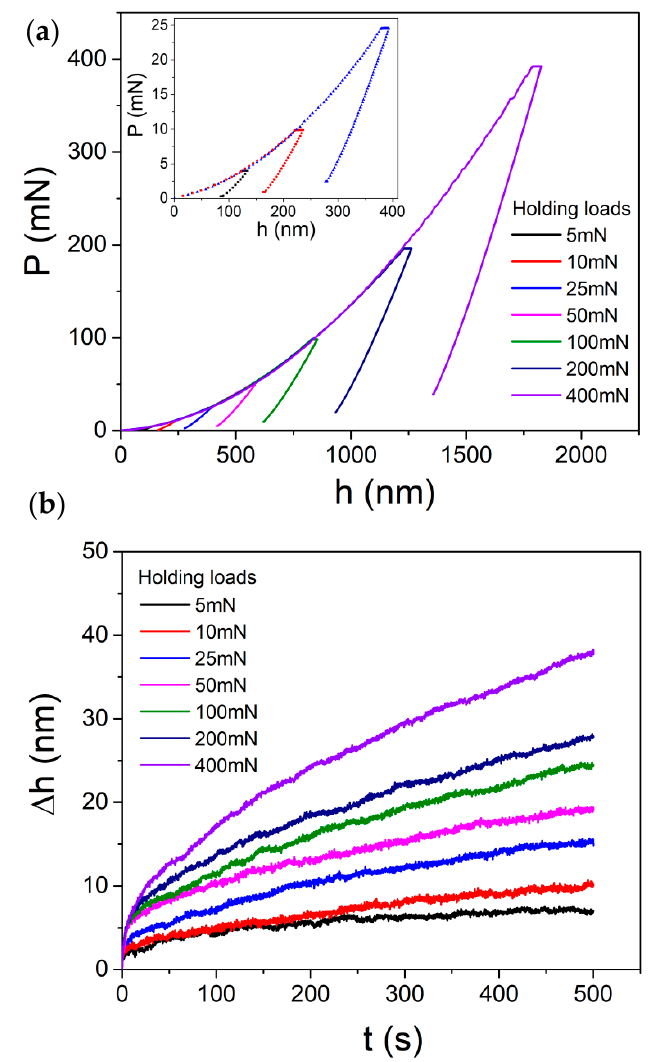
Figure 1. ( a ) The typical creep P-h curves at various holding depths under Berkovich indenter. P-h curves at shallow depths were enlarged in the inset. ( b ) Creep displacements at various holding loads were plotted with holding time.